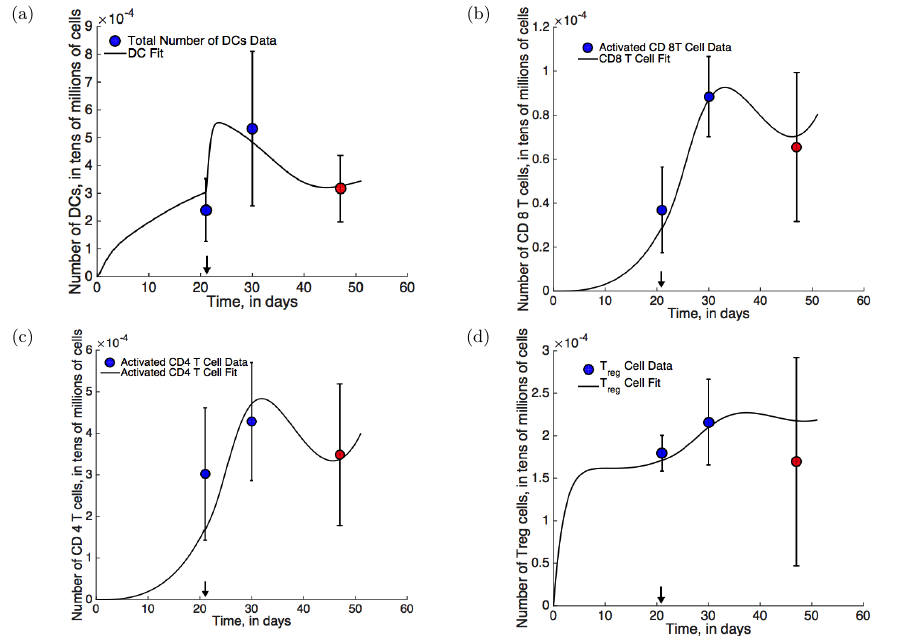
Figure 2. Model fits to tumor xenograft time-course data of: ( a ) total tumor cell number; ( b ) number Figure 1: ADT model fits: Best fit to data of a.) total number of tumor cells, b.) number of apoptotic tumor cells pre-ADT. Black arrows indicate when treatment with ADT was initiated, of apoptotic tumor cells c.) total number of DCs, d.) number of activated CD8 + T cells, e.) number of activated CD4 + T cells, f.) number of T reg cells found in [ ? , ? , ? ]. The arrow indicates blue circles together with error bars represent experimental data and solid lines show best fit model when treatment with ADT began. simulations. Data taken from [28,29].